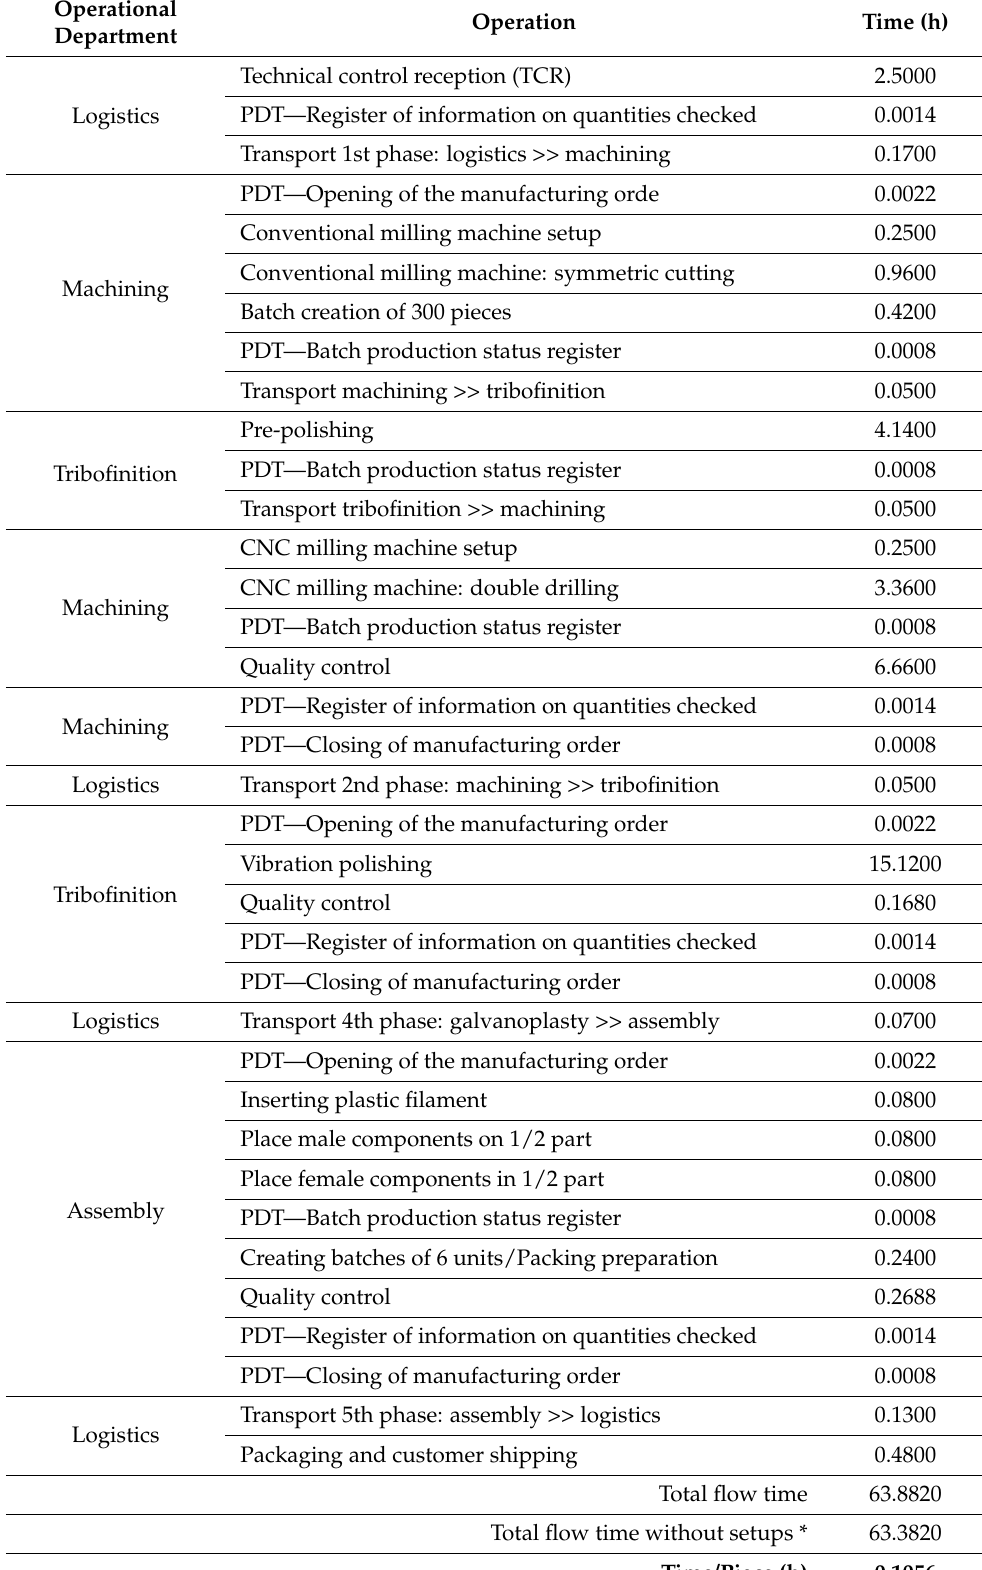
Table 10. Operating times from pilot test for production flow of the “ring”.